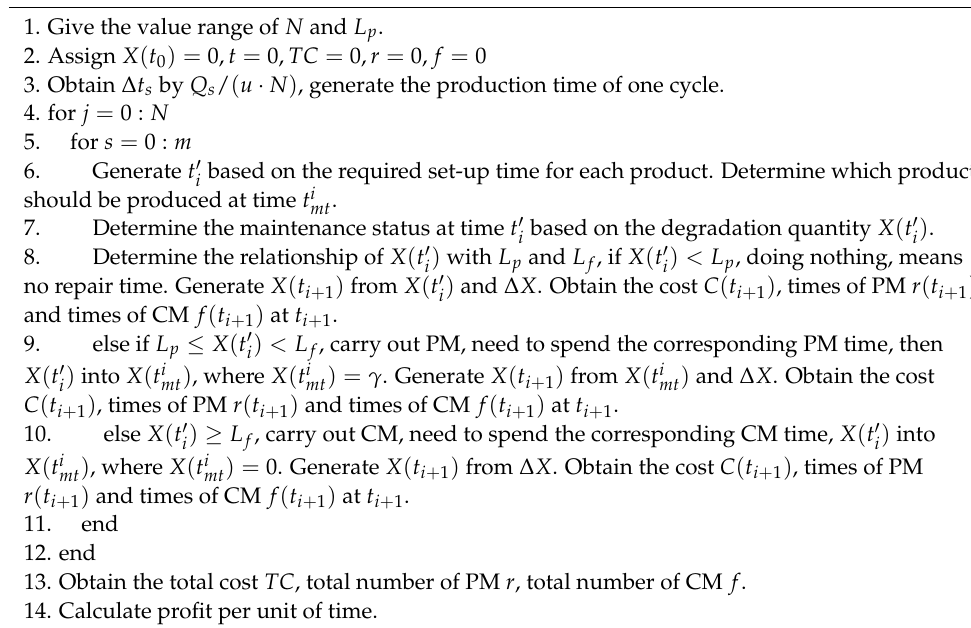
Algorithm 1. Computation algorithm for the